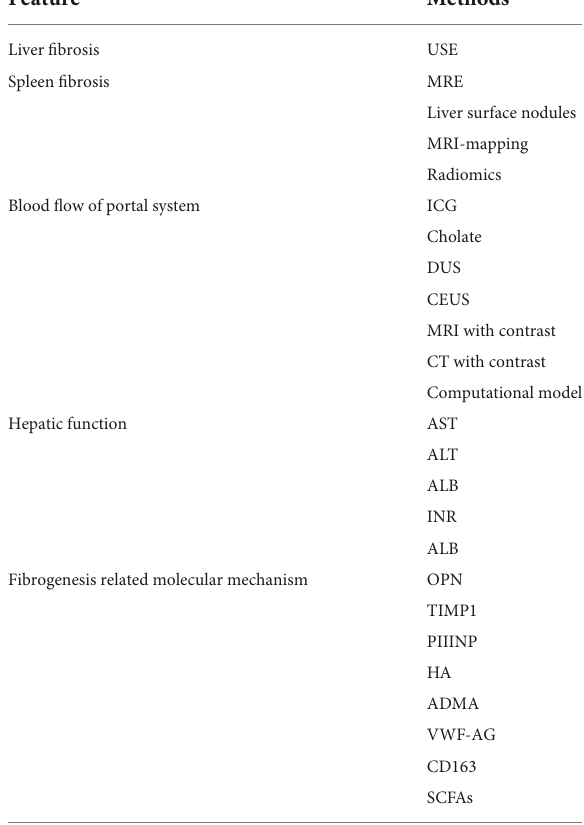
TABLE 8 Different lesions correspond to the